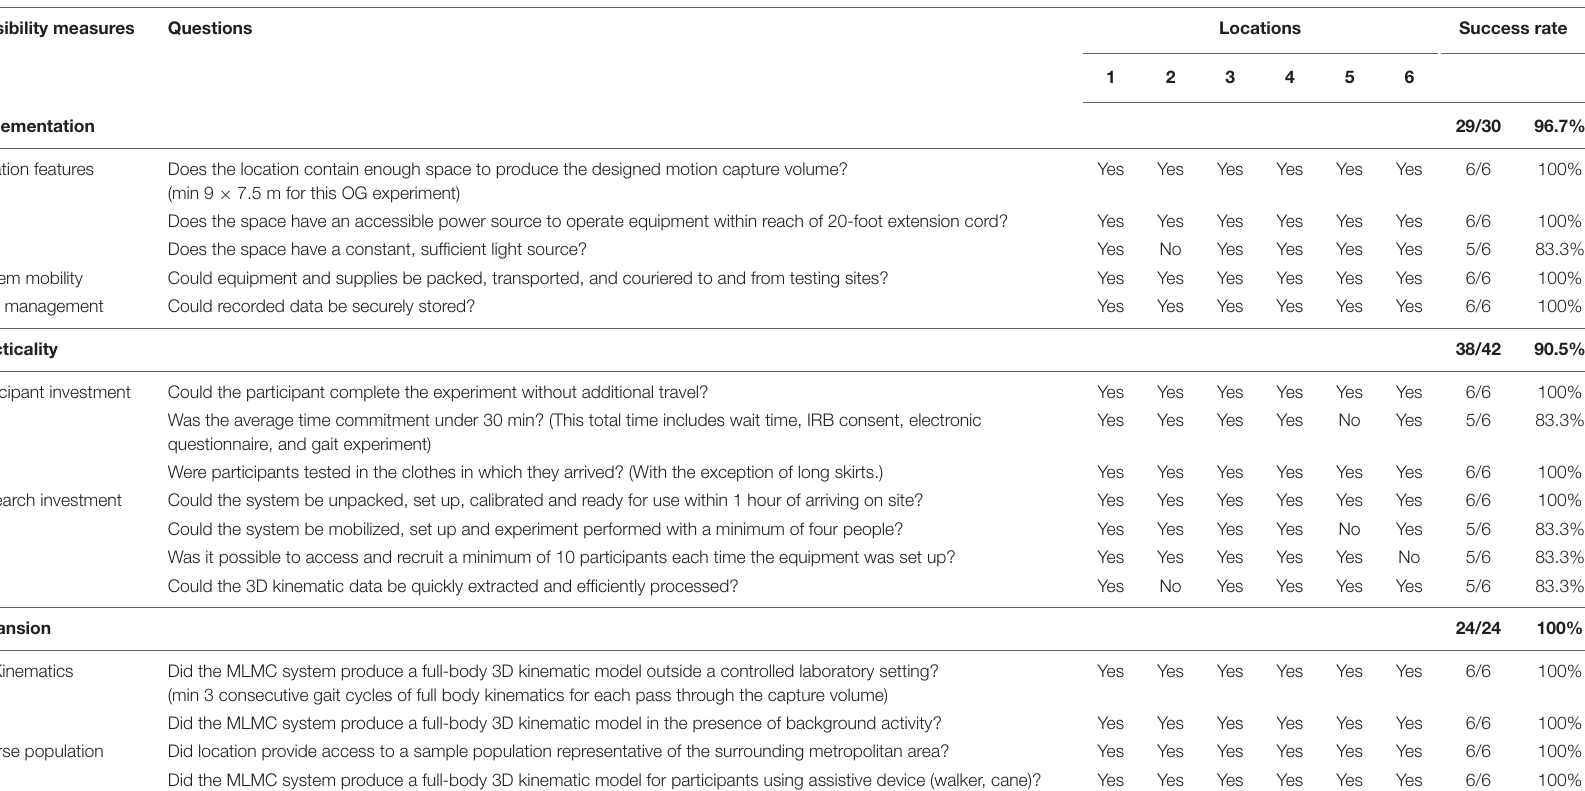
TABLE 1 | Overview of feasibility measures assessed at each of the six experimental locations. Feasibility measures Questions